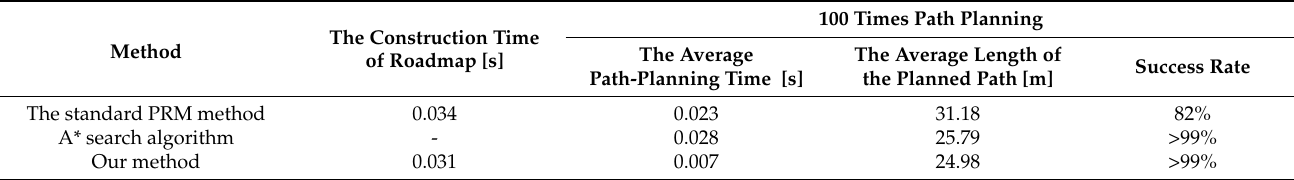
Table 4. Comparison of algorithm